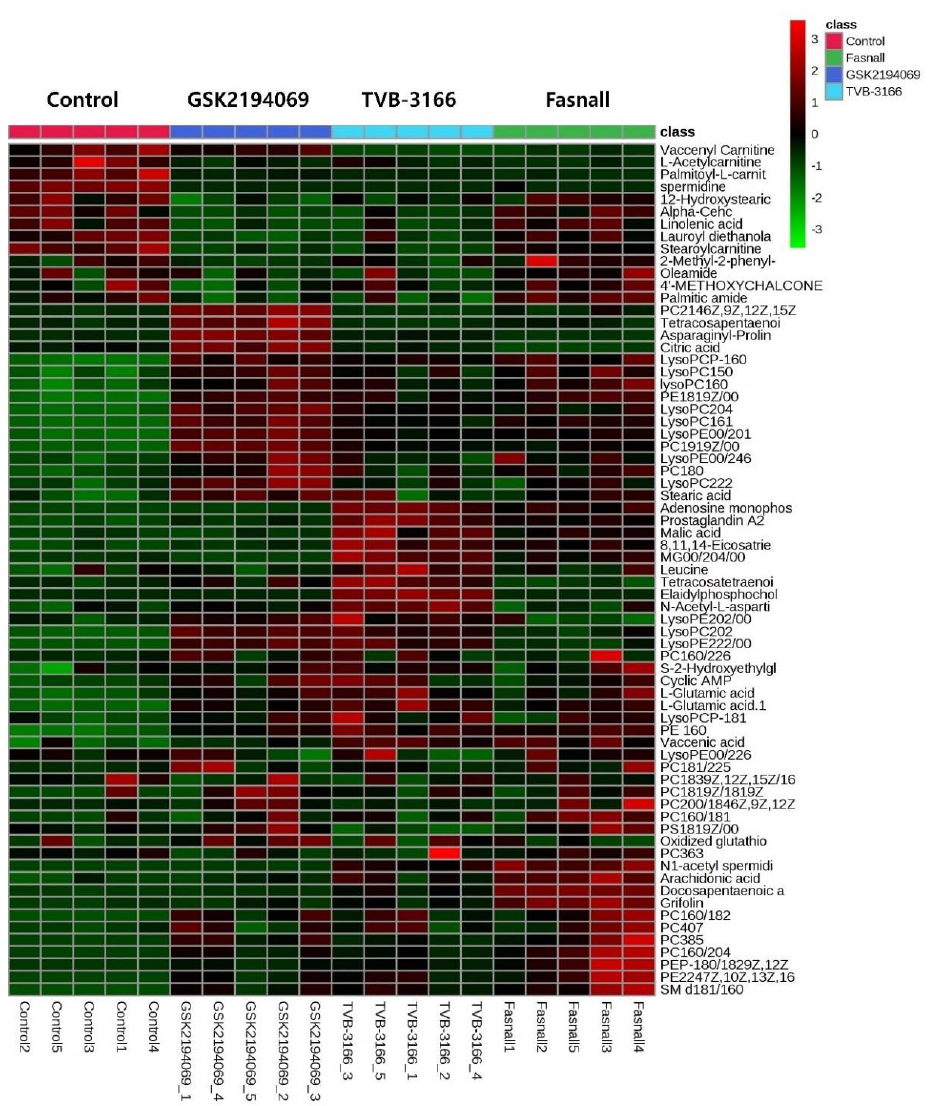
Figure 2. Hierarchical cluster analysis of identified metabolites. The metabolites were clustered, and shades of green and red represent downregulation or upregulation.